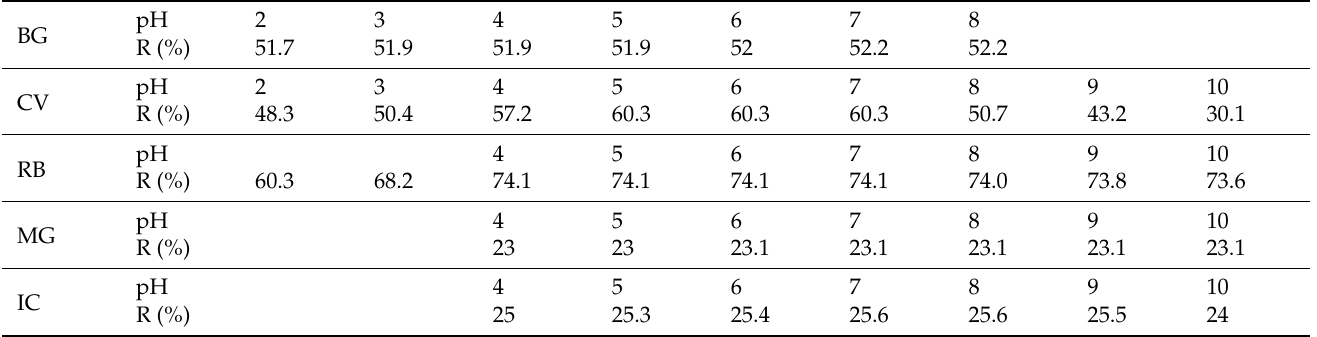
Table 6. Dependence of the degree of extraction of the dyes by the composite (5% GO) on the